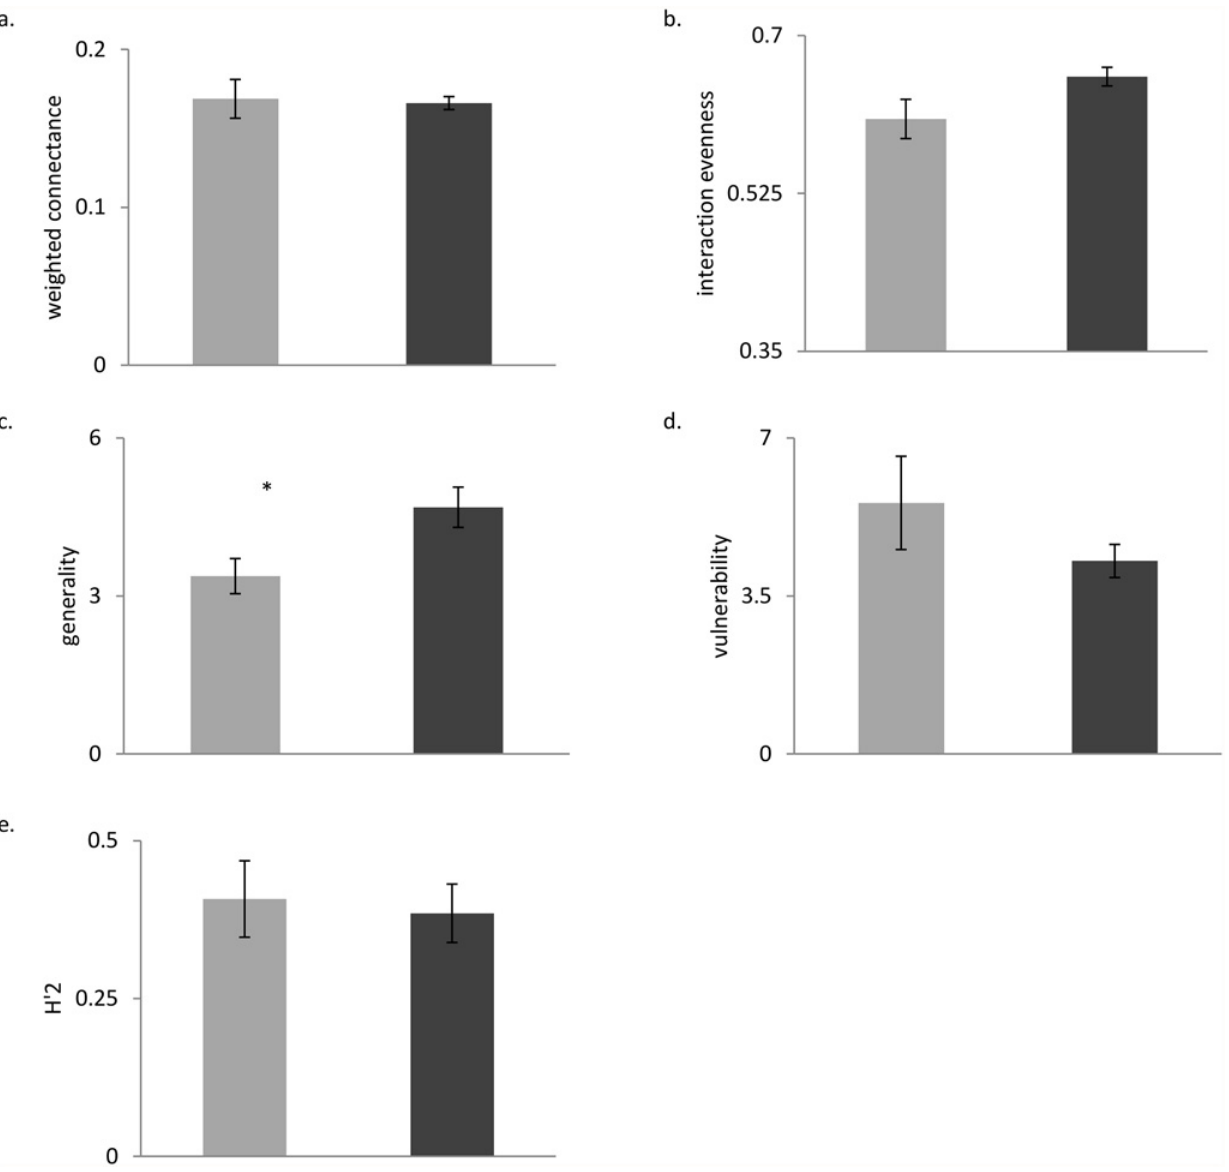
Fig 6. Quantitative network parameters Comparison of quantitative network parameters calculated from insect-flower interaction networks created by sampling four invaded Irish woodland insect- communities during (light gray) and after (dark gray) flowering of Rhododendron ponticum . Network parameters analyzed include a.) quantitative connectance, b.) interaction evenness, c.) generality, d.) vulnerability and e.) H ’ 2 . * indicates a significant difference between the two rounds of sampling (paired t-test, p < 0.05). Plots show mean parameters per sampling round across all four sites, and vertical bars show the standard error of each